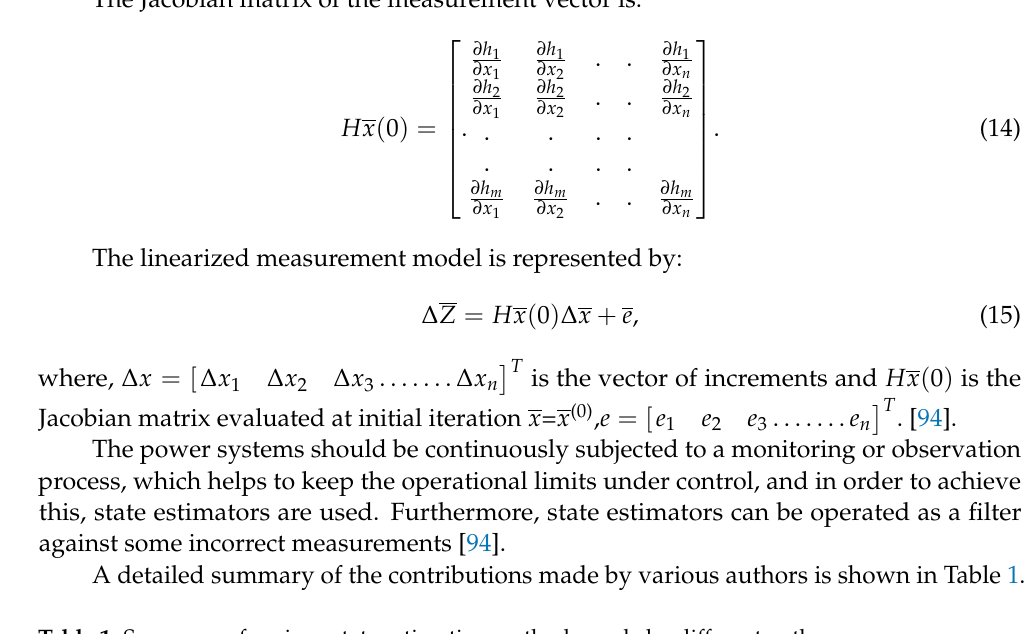
Table 1. Summary of various state estimation methods made by different